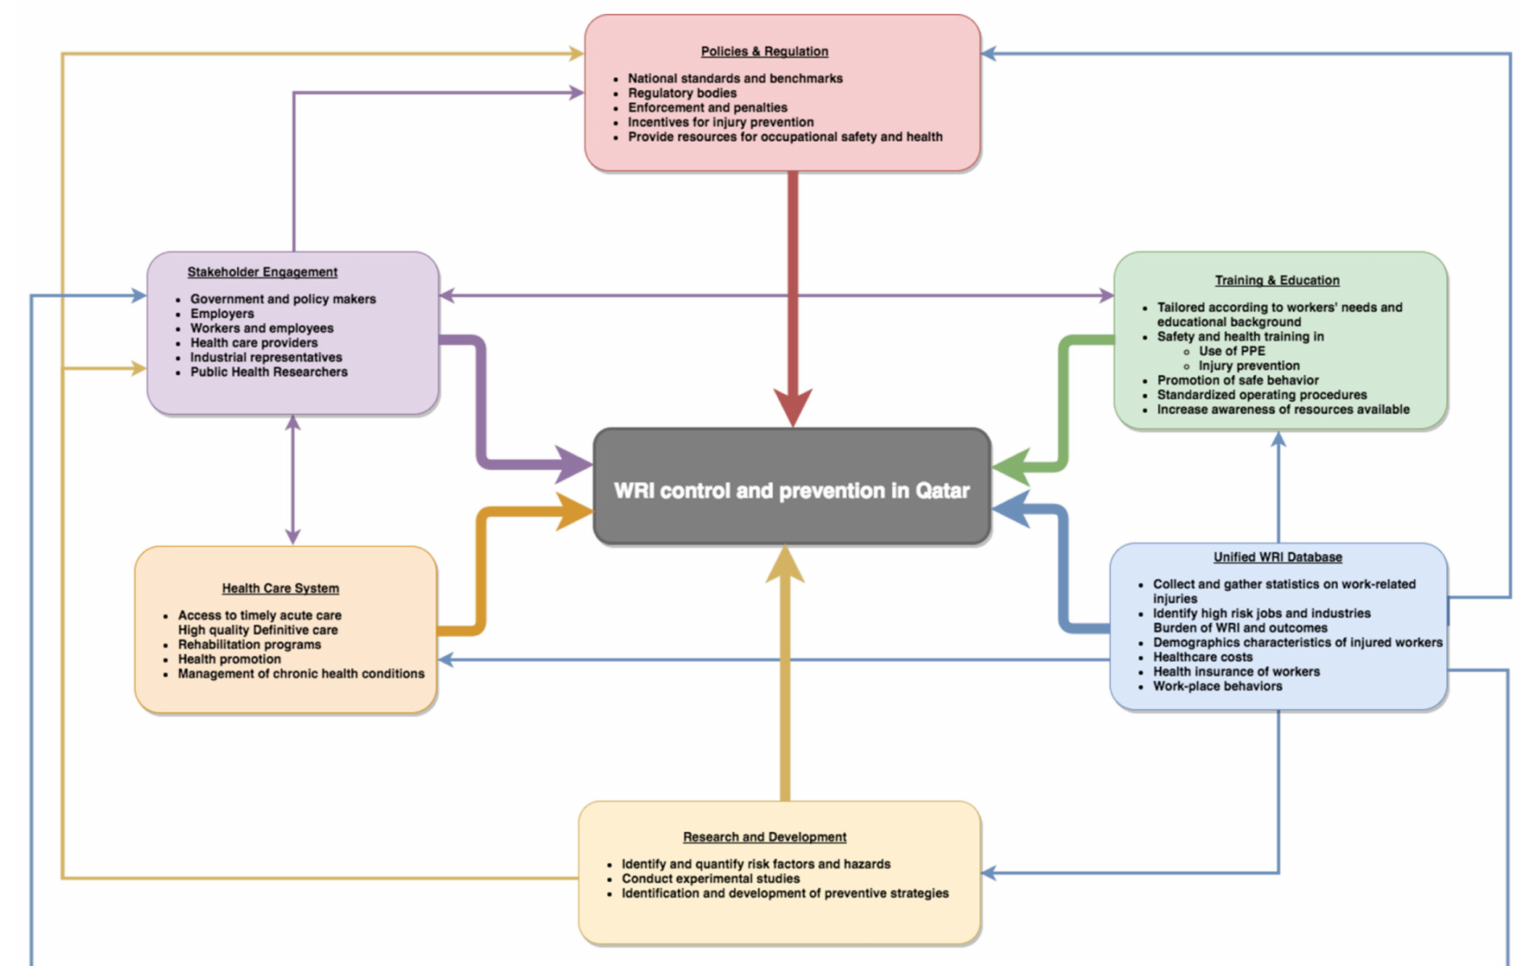
Figure 1. A comprehensive framework for WRI prevention and control in Qatar (reproduced with the permission